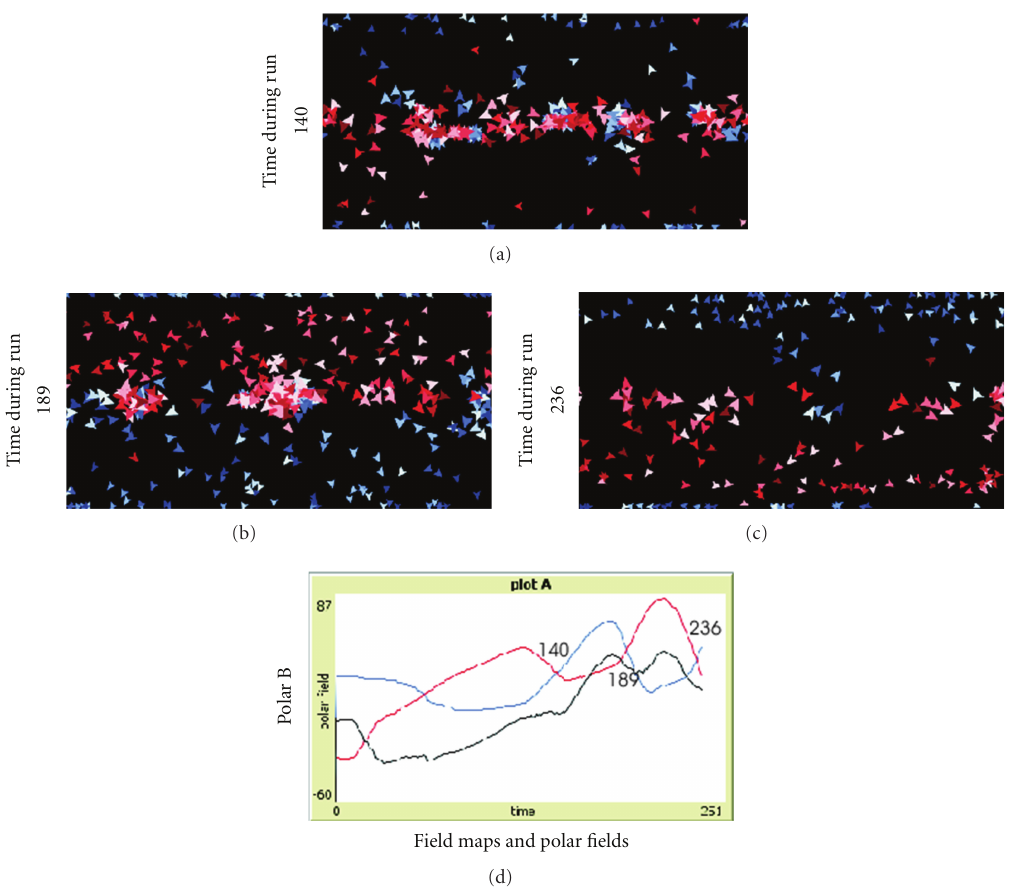
Figure 8: The Sun appearing as a monopole. This model is obtained by using a 0 value for the “quad-blaster” setting. The lower graph shows the polar fields, again a Plot A type graph of the polar field variation seen in many of the preceding figures. The Plot A graph has the three colored curves: blue, red, and black. The blue curve displays the amount and sign of the magnetic flux in the northern magnetic pole; the red curve similarly counts the mean field in the Southern polar region, and the black curve marks the Absolute Value Sum of the red and blue curves, placed 60 units downwards, for increased clarity. The polar fields overall, are observed drifting well into the positive arena (thus with both polar regions positive, with the assumption of Maxwell’s divergence B condition, one may assume that the equatorial field of the Sun balances the magnetic flux), indicative of a quadrupole moment, and these three field maps are shown by the three graphs above indicated by the times. These are all forays of one sign, but either sign is equally likely. This upward drift indicates increasingly positive or blue polar fields (at the poles) and negative or red equatorial fields. The solar fields calculated by the model are not monopolar since blue and red entities always have identical numbers, but rather quadrupolar. This leads to the false impression at Earth, of a predominant non-zero solar magnetic polarity at low latitudes to those who choose this